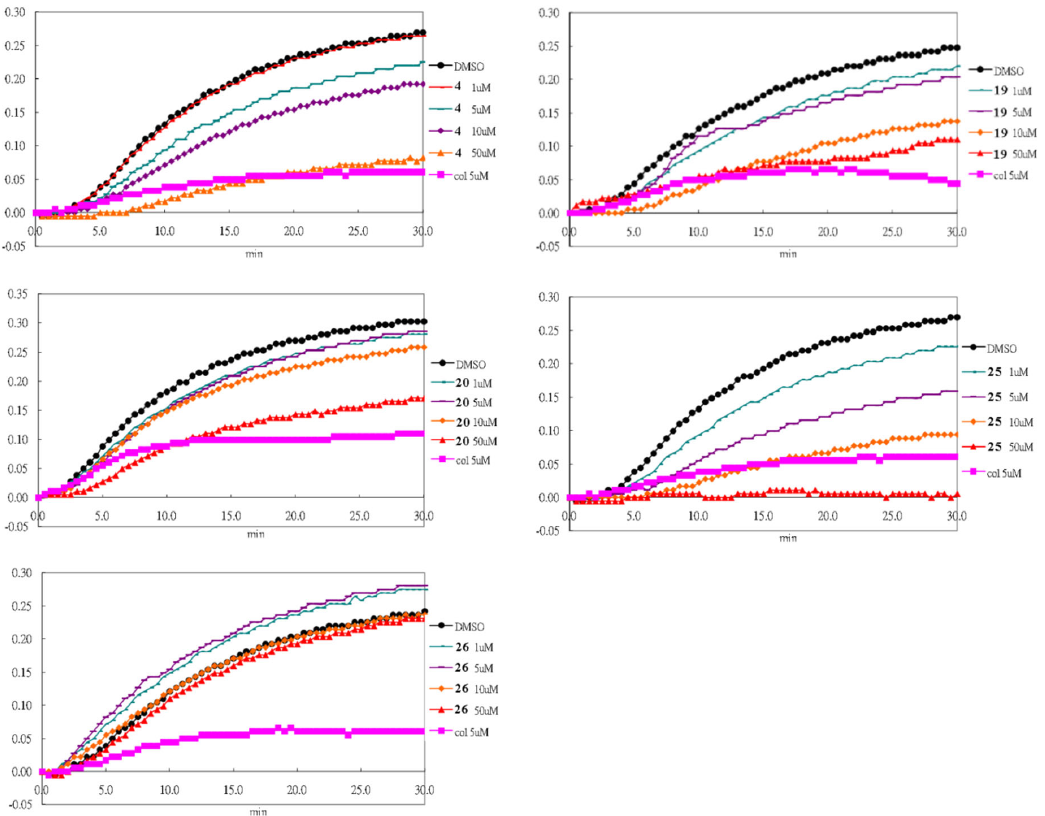
Figure 2. Inhibition of Tubulin Polymerization by Compounds 4 , 19 , 20 , 25 , and 26 . MAP ‐ rich tubulins were incubated at 37 °C in the absence or presence of test compounds. Absorbance at 350 nm was measured every 30 s for 30 min and is presented as the increased polymerized